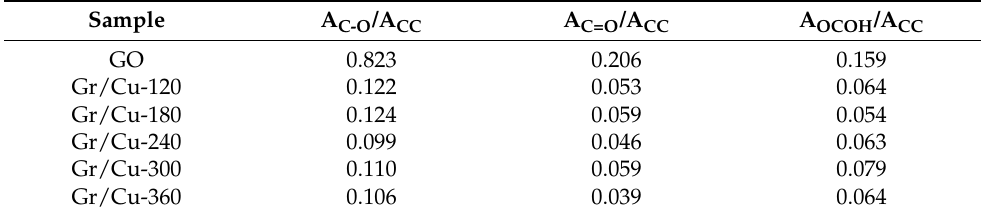
Table 2. The peak area (A) ratios of the oxygen-containing functional bonds to the C-C bonds of the GO and Cu-Gr samples with different deposition times.